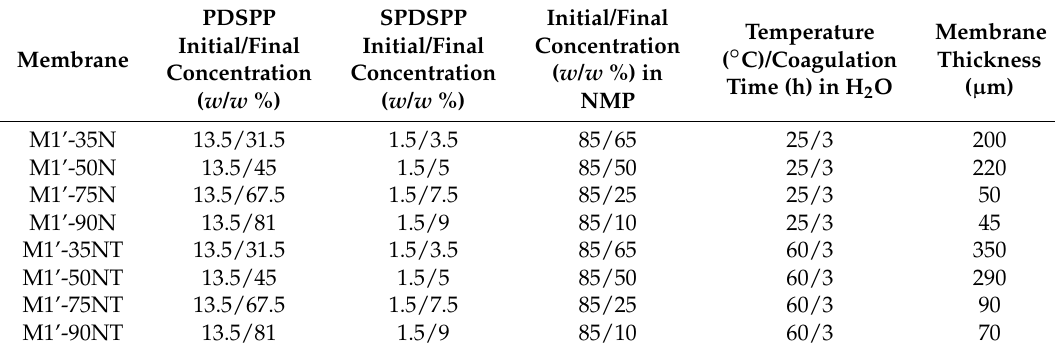
Table 1. Preparation of membranes with 90/10 w/w PDSPP/SPDSPP in NMP at 5% or 15% w / w ,